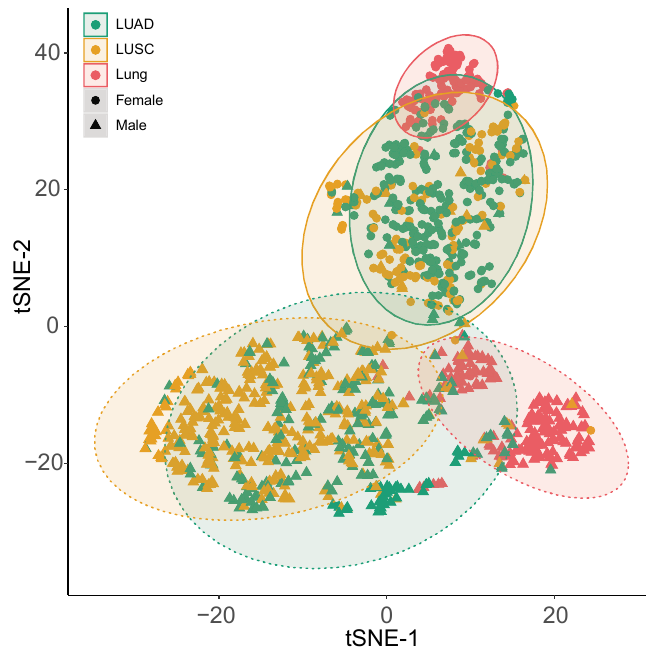
Figure 4. Clustering of tumour and healthy lung samples in a 2D map using t-SNE algorithm based on the normalized expression levels of XIST, TSIX, hnRNPu , Bcl-2 , and BRCA1 . tSNE-1 and tSNE-2 are the tSNE projection axes. Cancers 2020 , 12 , x